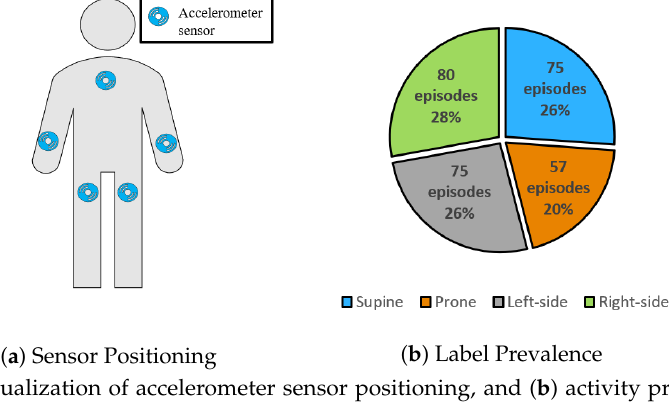
Figure 3. ( a ) Visualization of accelerometer sensor positioning, and ( b ) activity prevalence for the integrated